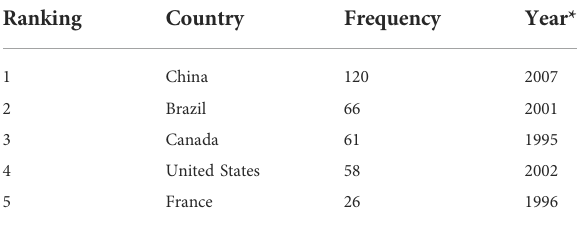
TABLE2Top fi vemostproductivecountriesinGHG-HRresearch fi